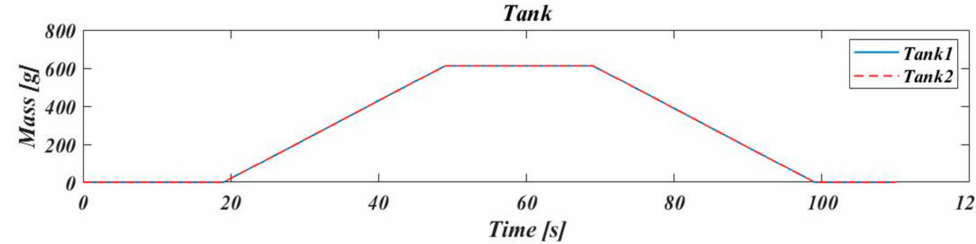
Figure 9. Time series of the mass changes in the forward and aft ballast tanks, respectively.